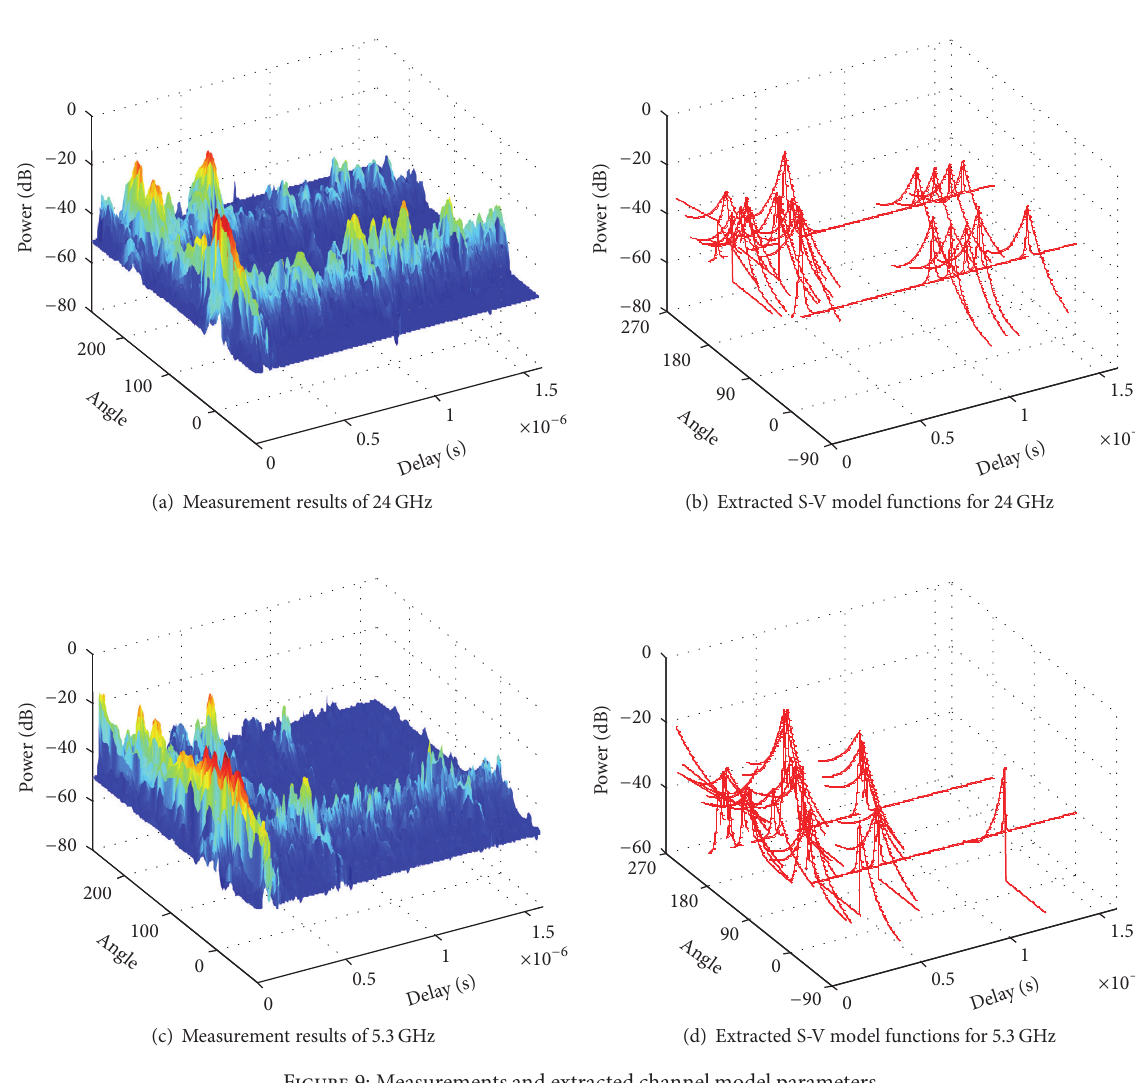
Figure 9: Measurements and extracted channel model